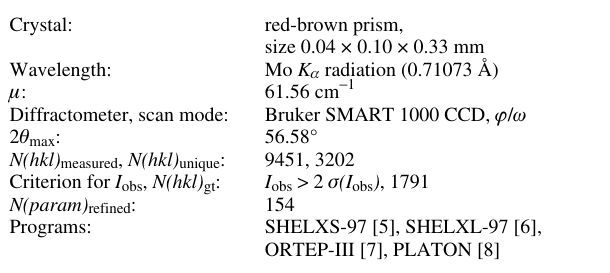
Table 1. Data collection and handling.